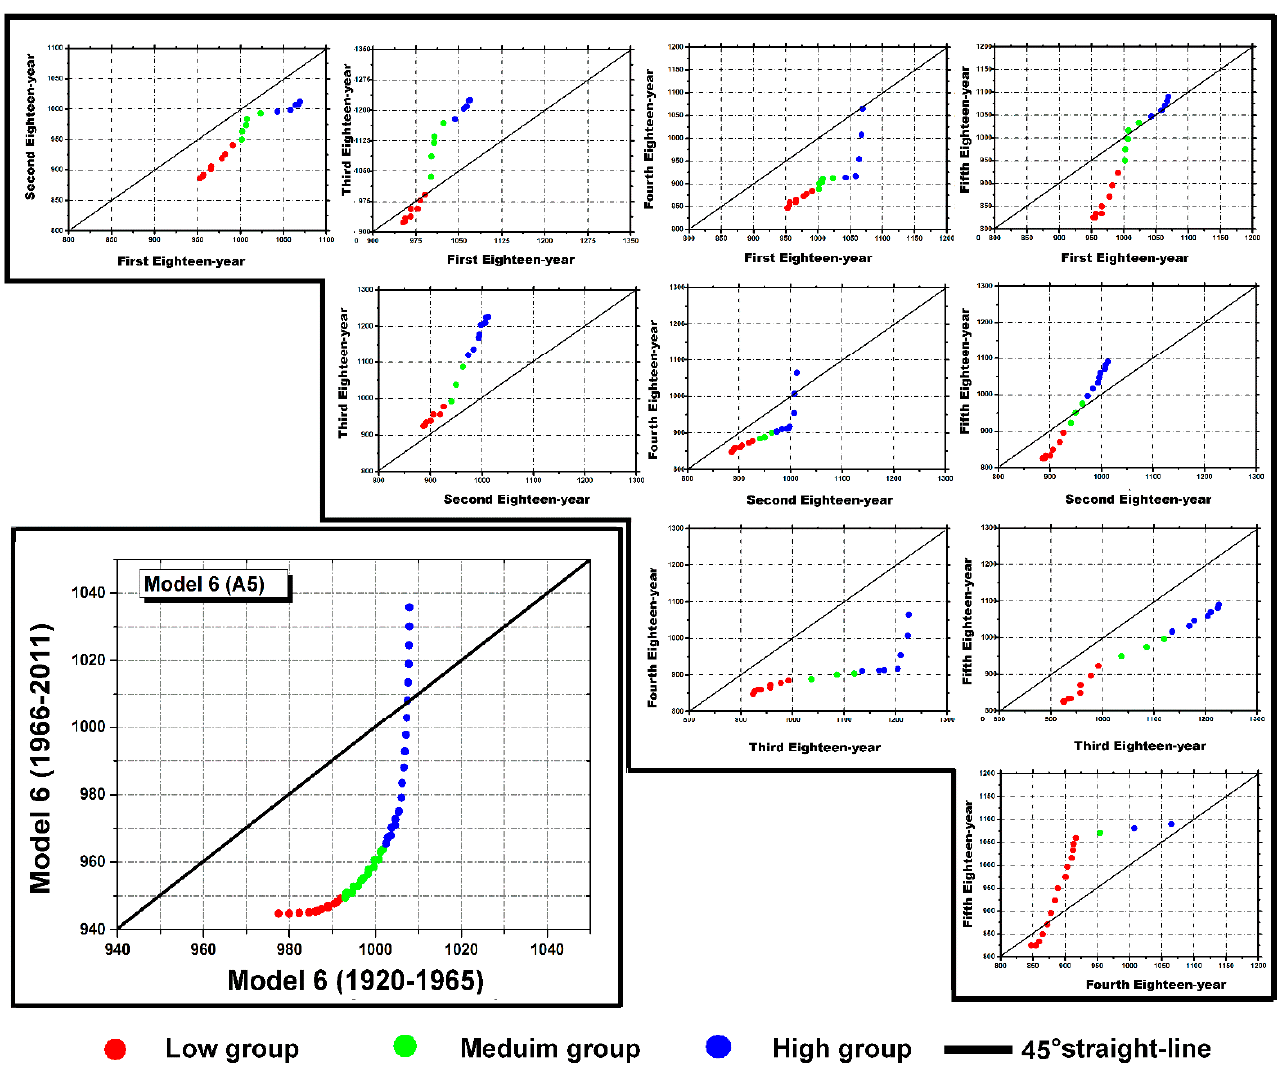
Figure 8. Triangular trend analysis methodology applied on rainfall Model (M21) resulting from DWT (ITTM − DWT: hybrid method) of Azazga station (ITM applied on model 6).